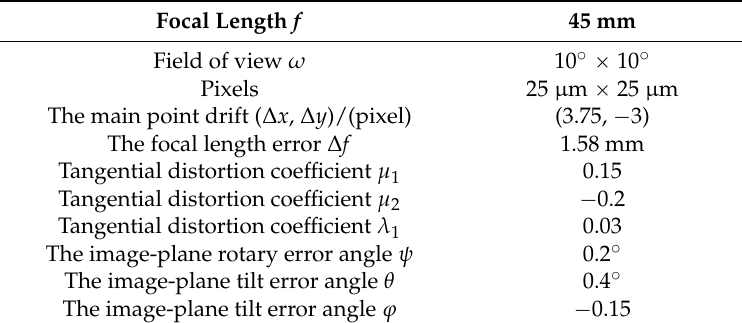
Table 1. The parameters of the star